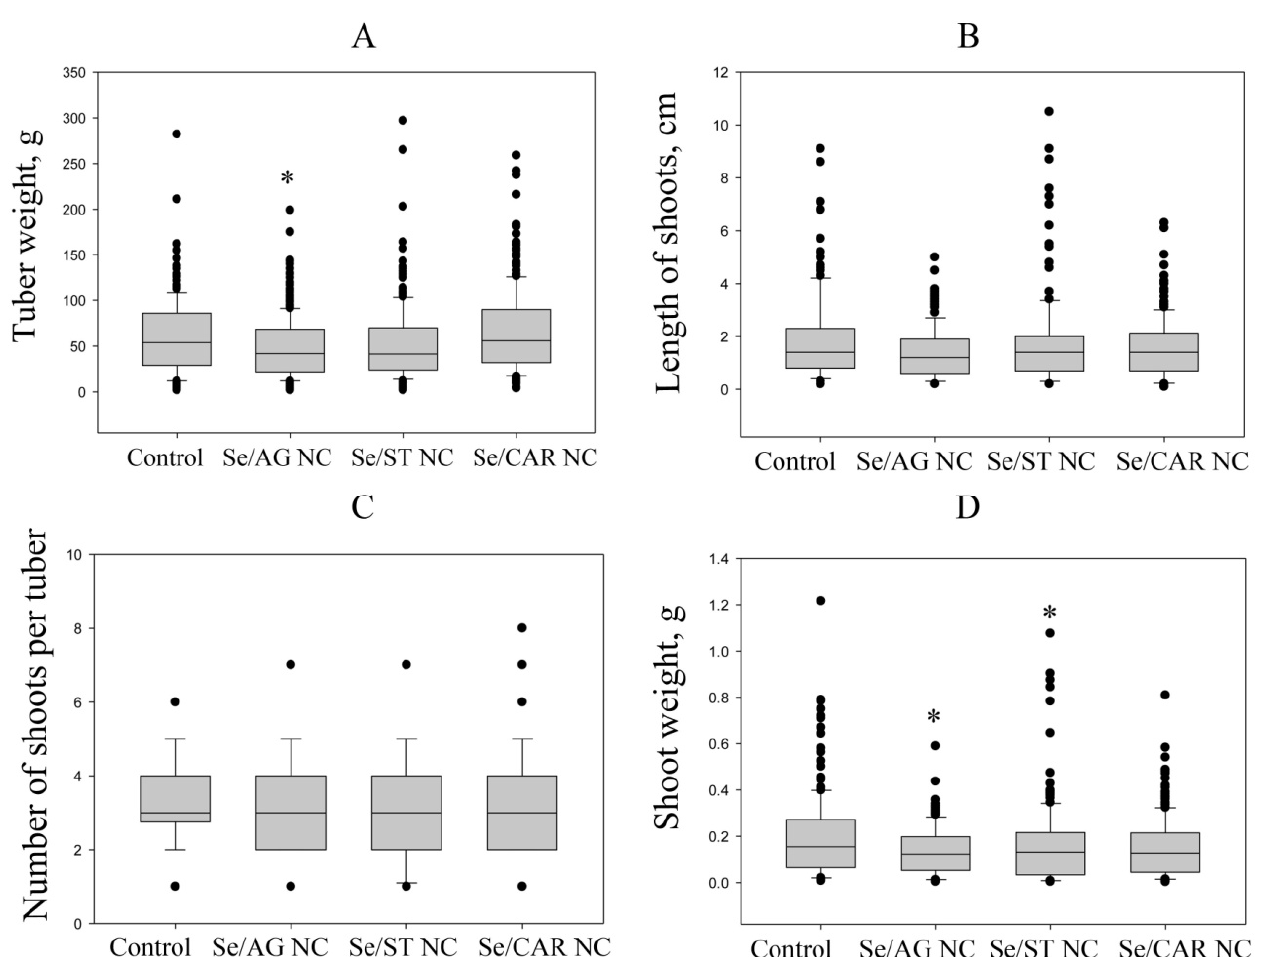
Figure 5. Box-plots of tuber traits ( A ) tuber wight, ( B ) length of shoots, ( C ) number of shoots per tuber, ( D ) shoot wight in the first generation obtained from plants grown from tubers treated with selenium (Se) nanocomposites (NCs) after 230 days of storage; * Significant differences from control at p ≤ 0.05 based on Kruskal–Wallis test. Se/AG NC, Se/ST NC and Se/CAR NC are arabinogalactan-